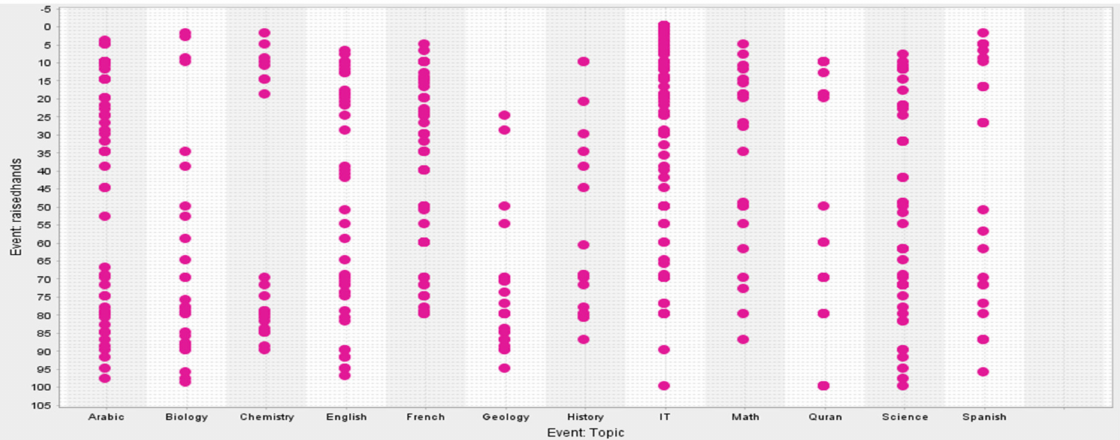
Figure 6. Dotted chart analysis showing the topic studied and hands